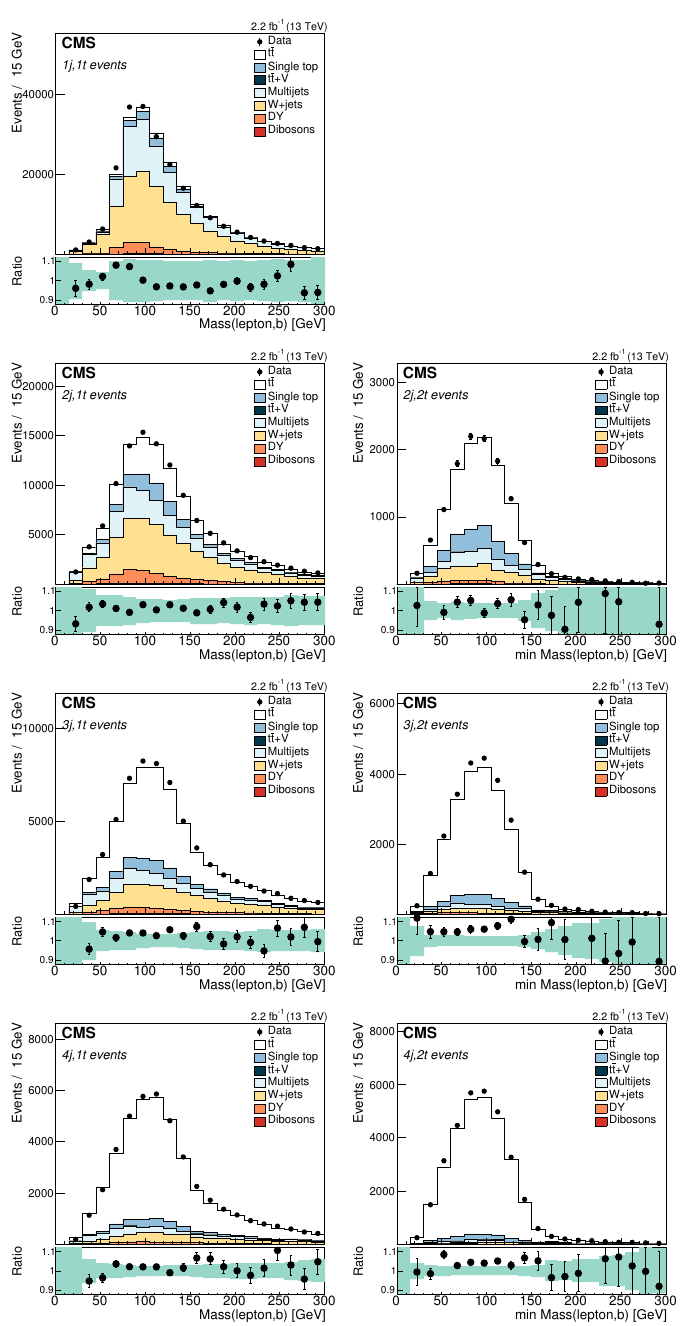
Figure 2 . Distributions in the observables used to (cid:12)t the data with the contributions from all leptons and charges combined. Panels on the left show the distributions in M ( ‘; b), and on the right in min M ( ‘; b), for events with one and two b-tagged jets, respectively. From top to bottom, the events correspond to those with 1, 2, 3, or at least 4 jets. The lower plot in each panel shows the ratio between the data and expectations. The relative uncertainty owing to the statistical uncertainty in the simulations, to the uncertainty in the normalization of the contribution from multijet events and to the systematic uncertainty in the total integrated luminosity is represented as a shaded band.